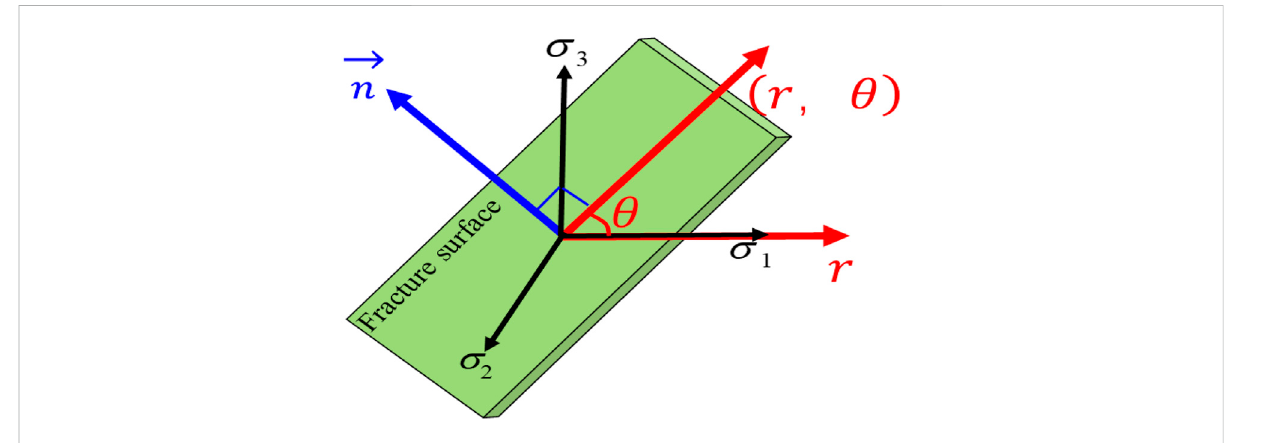
FIGURE 8 Diagram of calculating the fracture angle in polar coordinate